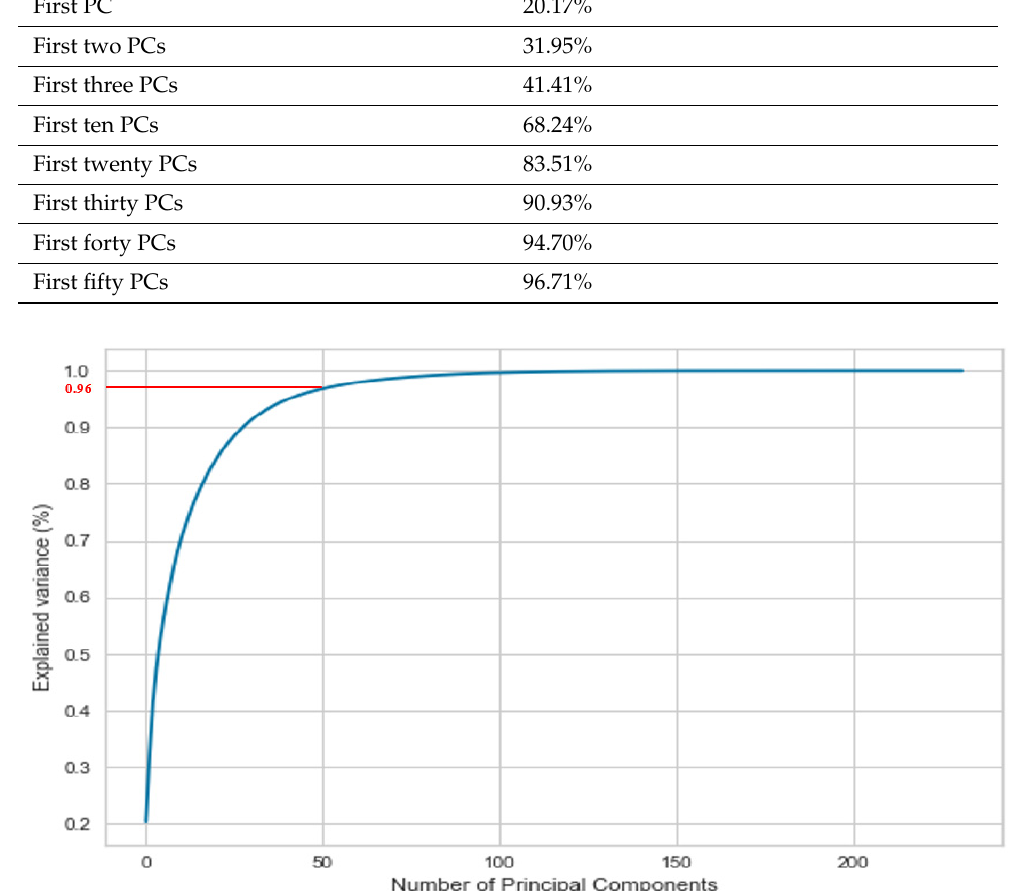
Table 3. Variance Explained by Cumulative PCs.